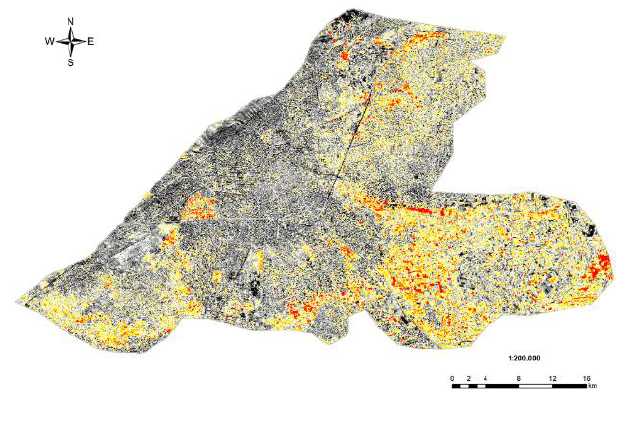
Figure 5 : Change between before the war and after the war, 1 Meter Sentinel